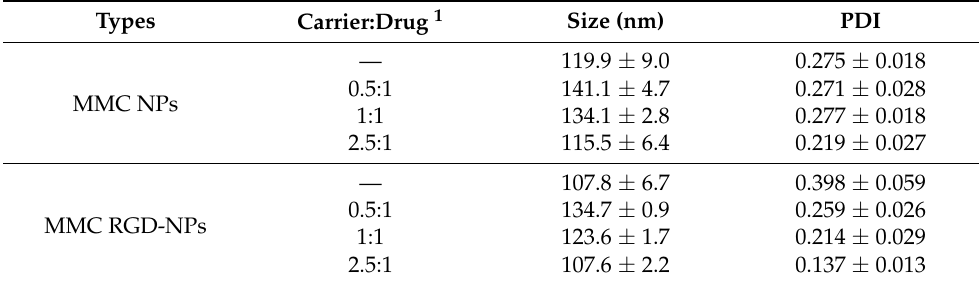
Table 2. The screening results of the drug and carrier molar ratios.